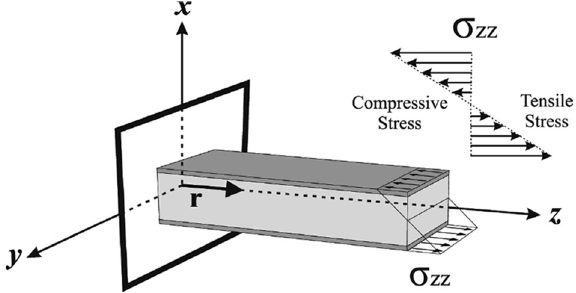
Figure 3. To cause bending in the direction of the x -axis (the main direction of the IPMC’s bending), mechanical stress should be induced in the direction of the z